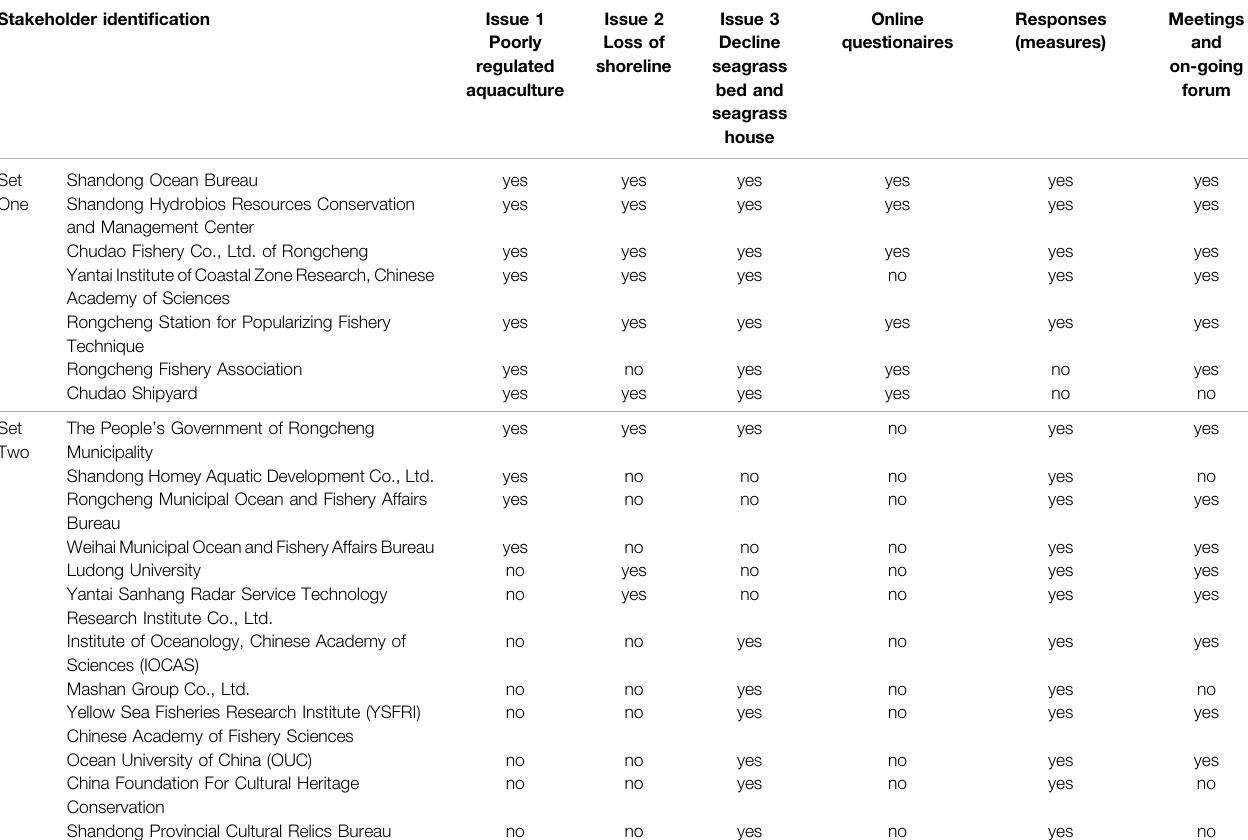
TABLE 2 | Stakeholder participation and the level of engagement. Stakeholder identi fi